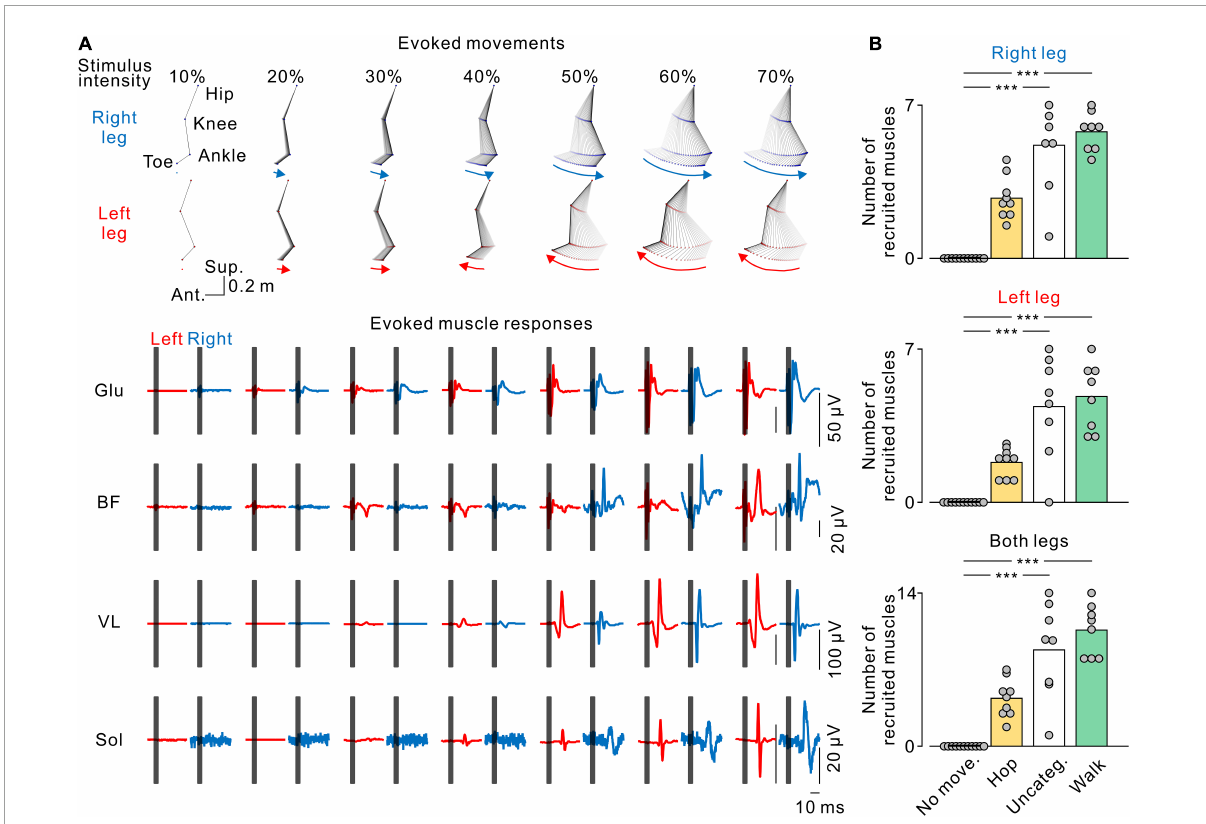
FIGURE7 Stimulus-evoked electromyography (EMG) responses in leg muscles. (A) The stick pictures show the evoked leg movements and are the same as in Figure 2A . The traces show the stimulus-evoked EMG responses in the gluteus maximus (Glu), biceps femoris (BF), vastus lateralis (VL), and soleus (Sol) muscles in the left (red) and right (blue) legs at each stimulus intensity. Dark gray areas in the EMG traces hide stimulus artifacts. (B) Number of muscles recruited by transvertebral magnetic stimulation. From top to bottom, the number of recruited muscles in the right, left, and both legs at each pattern of leg movement. No movement (No move., black), hopping-like movements (Hop, yellow), uncategorized movements (Uncateg., white), and walking-like movements (Walk, green) were defined by the same criteria as in Figures 1 , 3 . The values of the bars were averaged in each participant. Circles indicate the results of each participant. Significant differences were revealed by Dunn’s tests following Kruskal − Wallis one-way analysis of variance (*** p < 0.001).